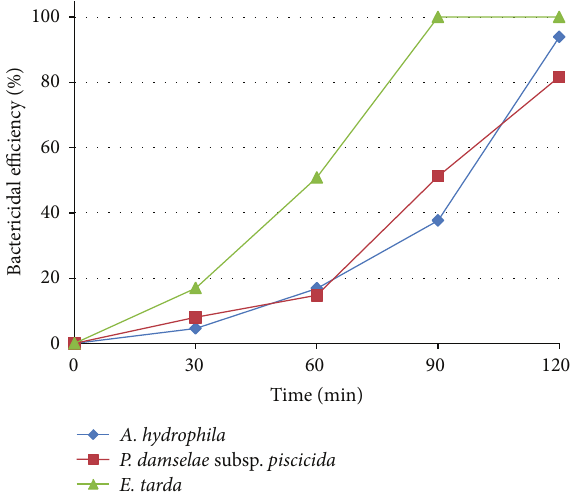
Figure 12: Bactericidal efficiency of 2.7 mg Ag-TiO 2 /Fe 3 O 4 to Aeromonas hydrophila ( ⧫ ), Edwardsiella tarda ( 󳵳 ), and Photobac- terium damselae subsp . piscicida ( ◼ ) under visible light.